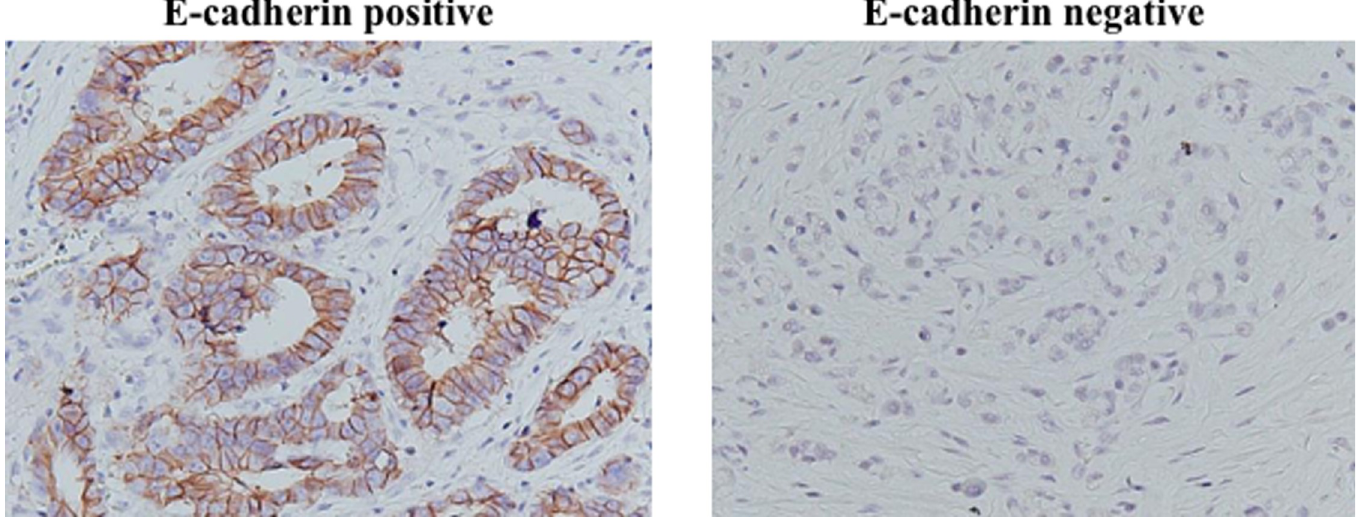
Fig 4. E-cadherin staining. E-cadherin was expressed mainly at the cell membrane.